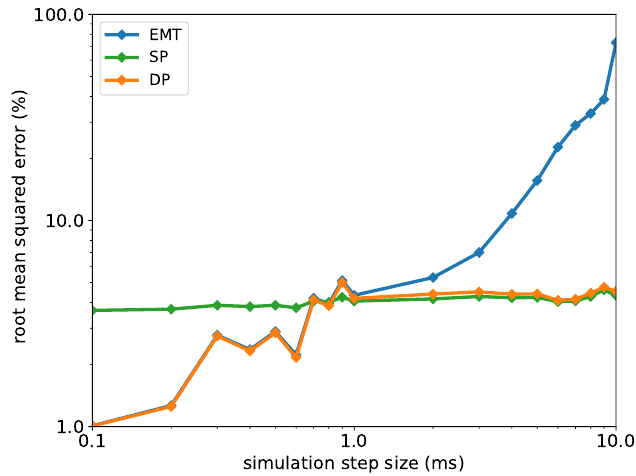
Figure 3. Root mean squared error (RMSE) of the simulation results of the voltage source inverter (VSI) with an open control loop depending on the simulation step